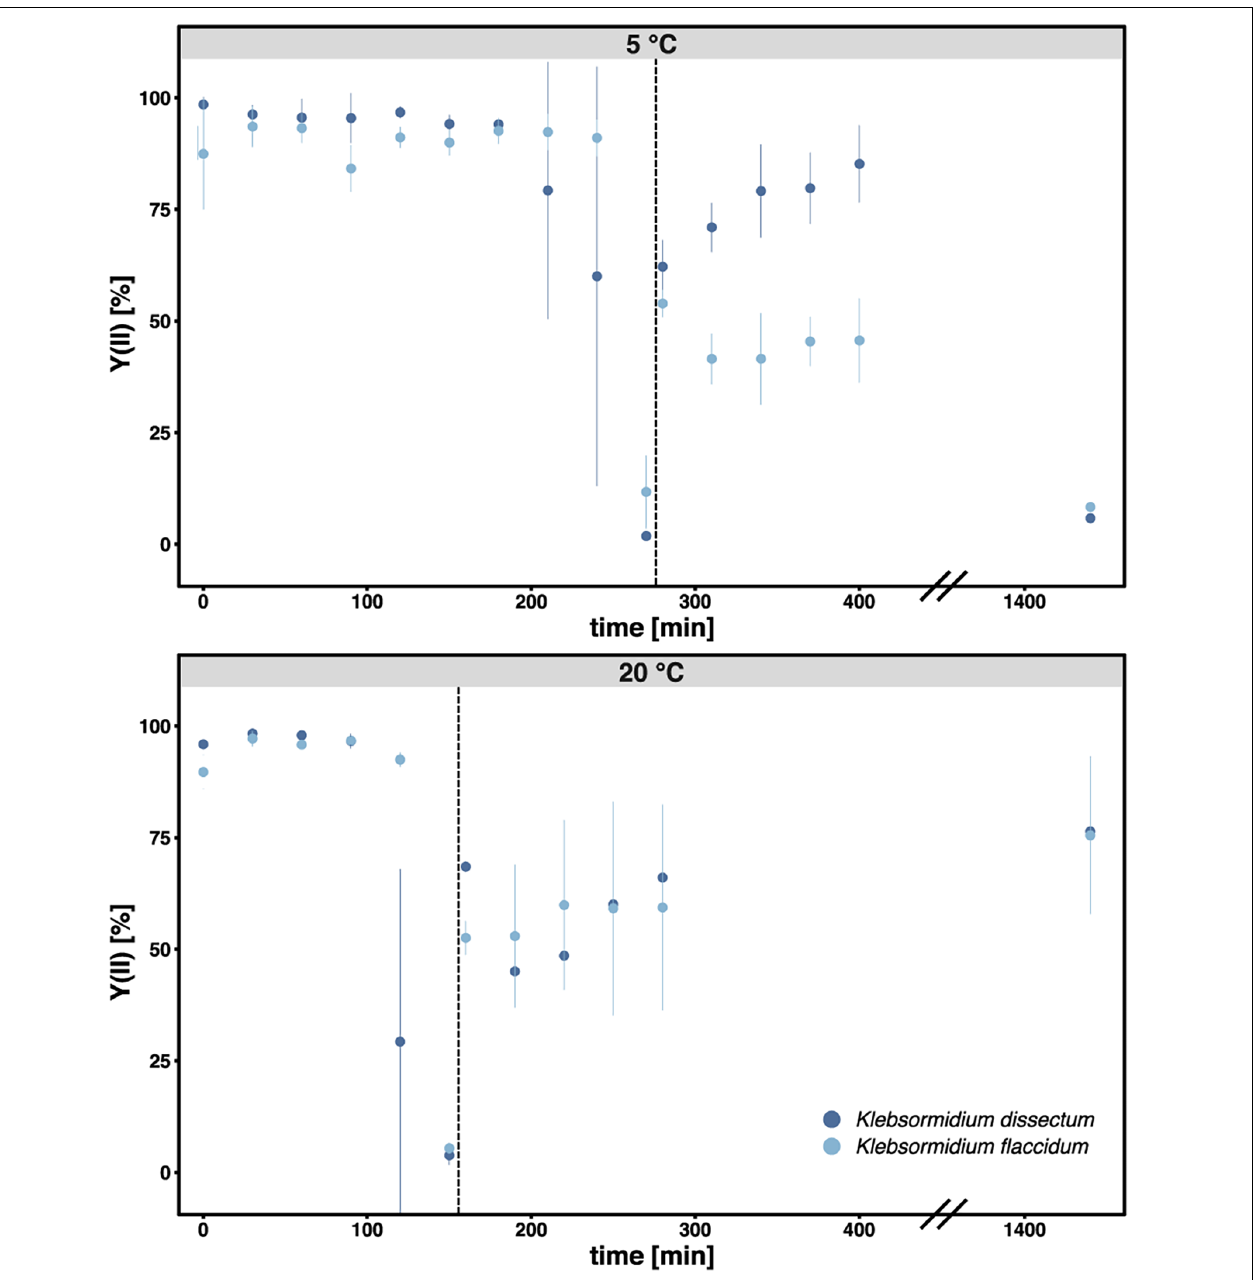
FIGURE 3 | The photosynthetic quantum yield of PS II [Y(II)] was measured over time during the course of desiccation for all samples. Each triplicate was measured three times at different positions of the filter. The bar indicates standard deviation while the dots indicate the mean value for each treatment. Dark blue: K. dissectum ; light blue: K. flaccidum . The vertical lines indicate the start of the recovery